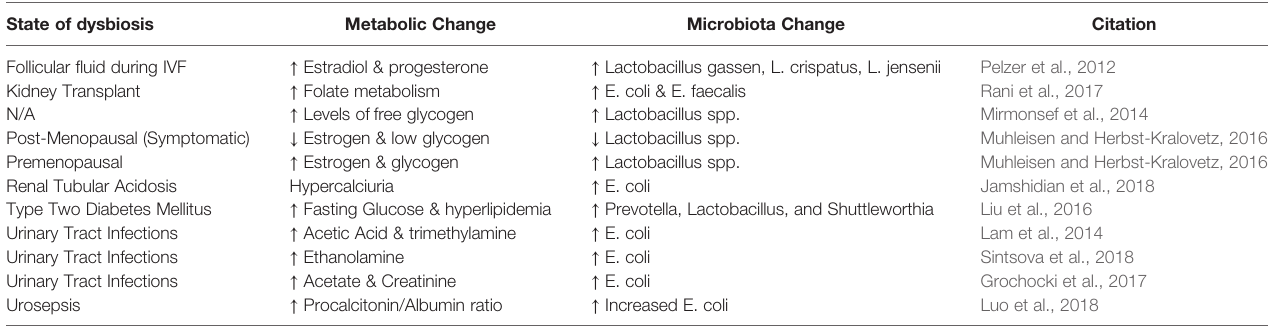
TABLE 2 | Microbial changes linked to host metabolic